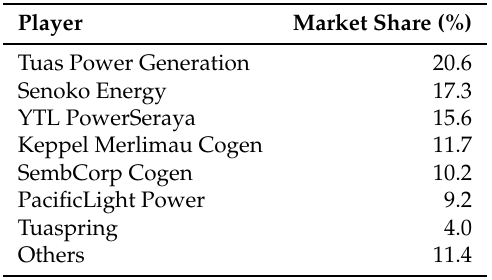
Table 5. Key generation players’ share in Singapore.